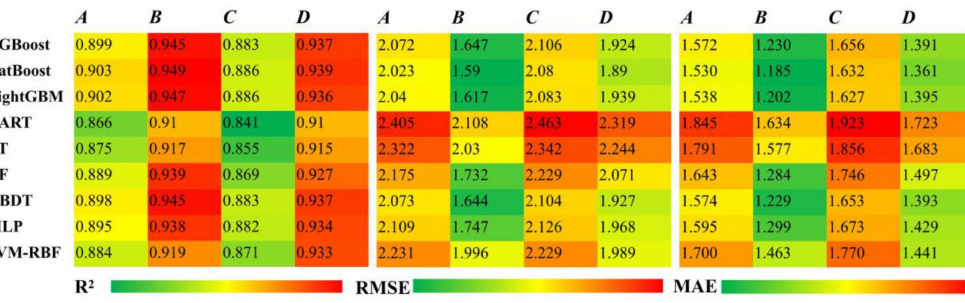
Figure 5. The R 2 , RMSE and MAE in different humidity zones.